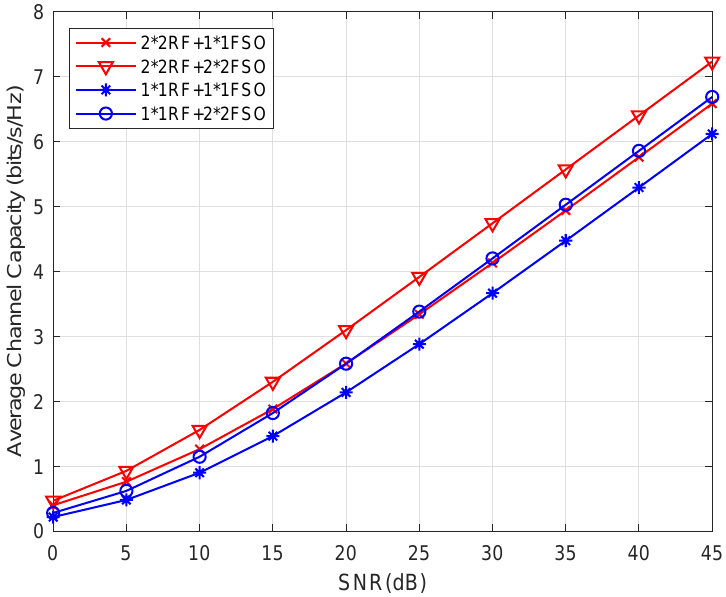
Figure 6. Average ergodic capacity of different schemes of MIMO mixed RF/FSO